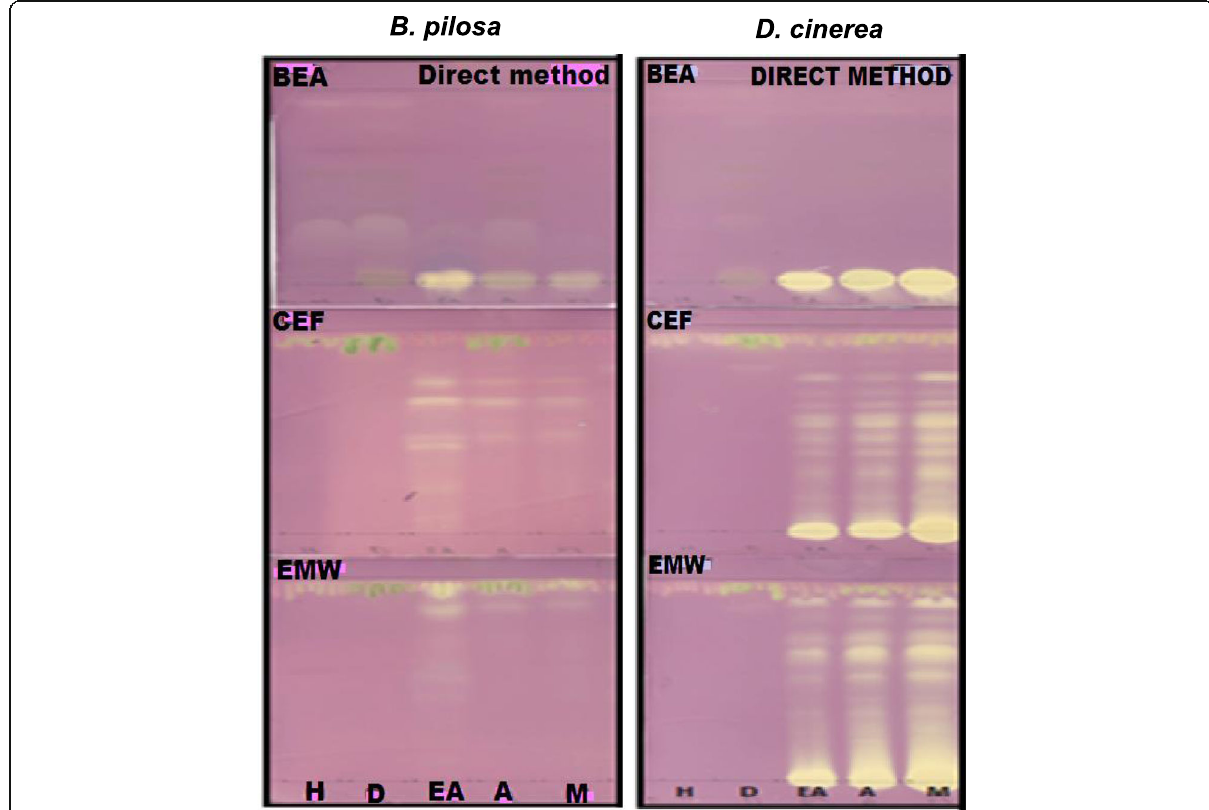
Fig. 3 The presence of antioxidant activity depicted by the yellow bands against a purple background. DPPH (0.2%) in methanol was used as an